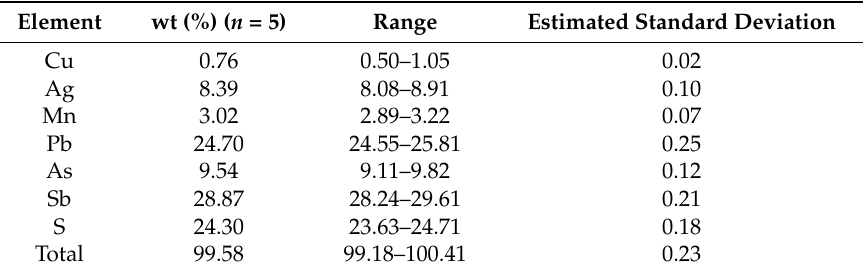
Table 1. Chemical data of